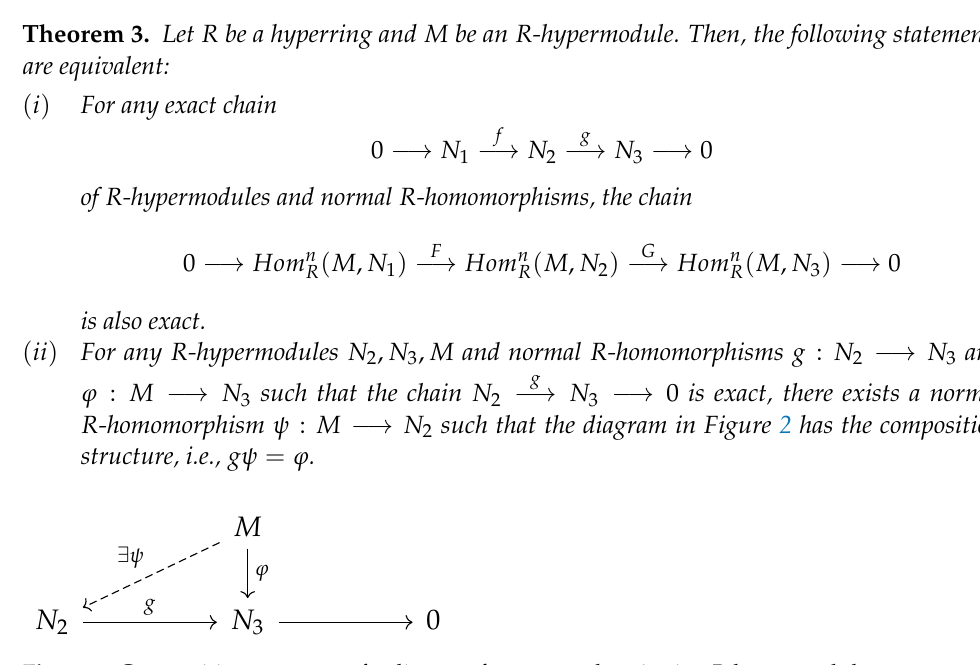
Figure 2. Composition structure of a diagram for a normal projective R -hypermodule